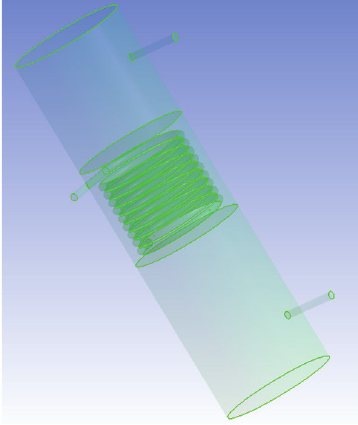
Figure 7: The 3D model of the separator.